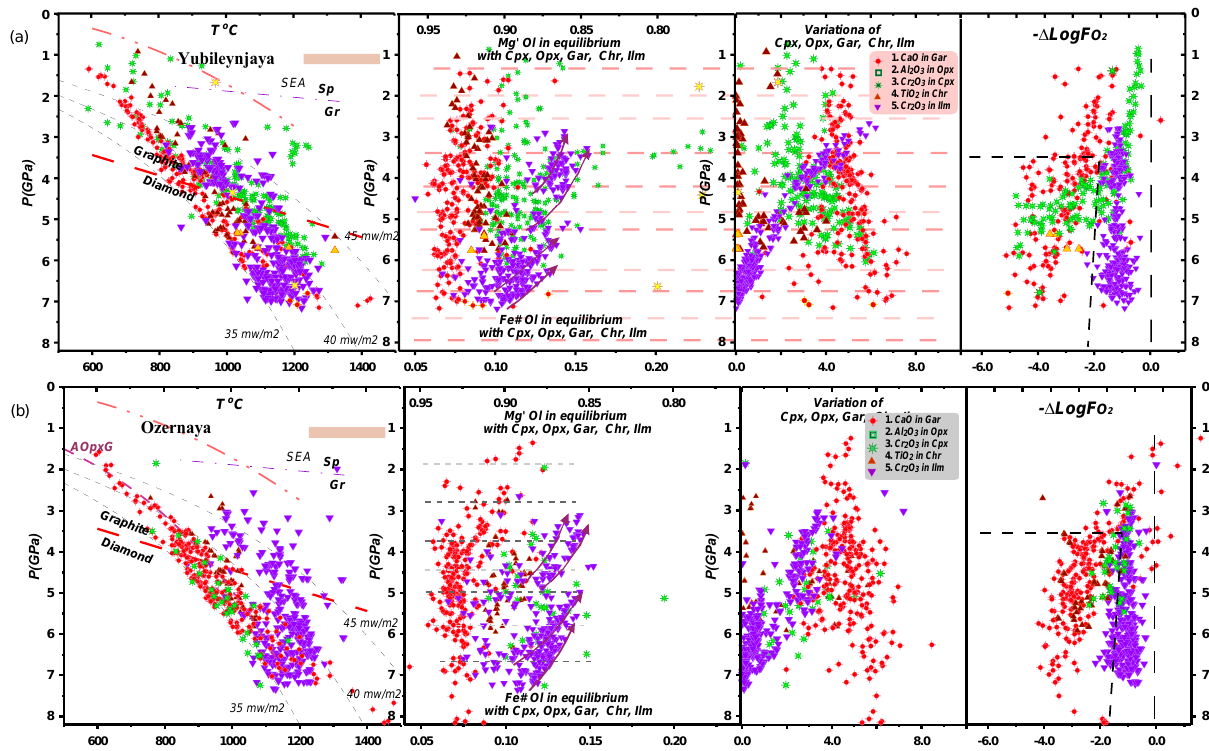
Figure 11. (a) PTXfO 2 estimates for minerals from the Yubileynaya pipe. Symbols are the same as for Fig. 9a. (b) PTXfO 2 estimates for minerals from the Ozernaya pipe. Symbols are the same as for Fig. 9a.